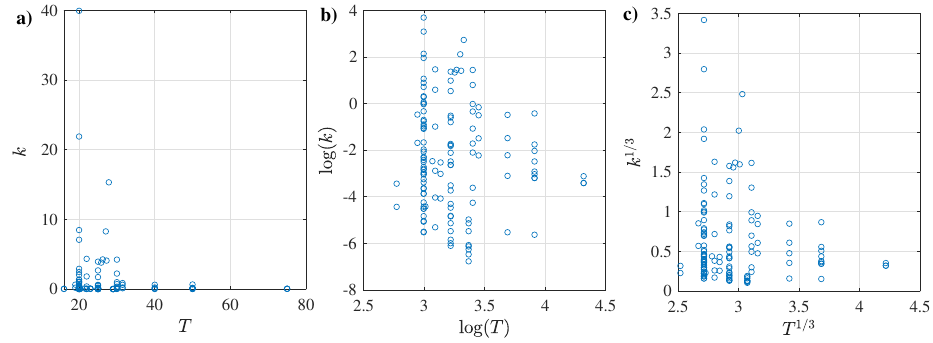
Figure 5. Scatter plot of ( a ) k vs T , ( b ) log ( k ) vs. log ( T ) , and ( c ) k 1/3 vs. wt 1/3 .